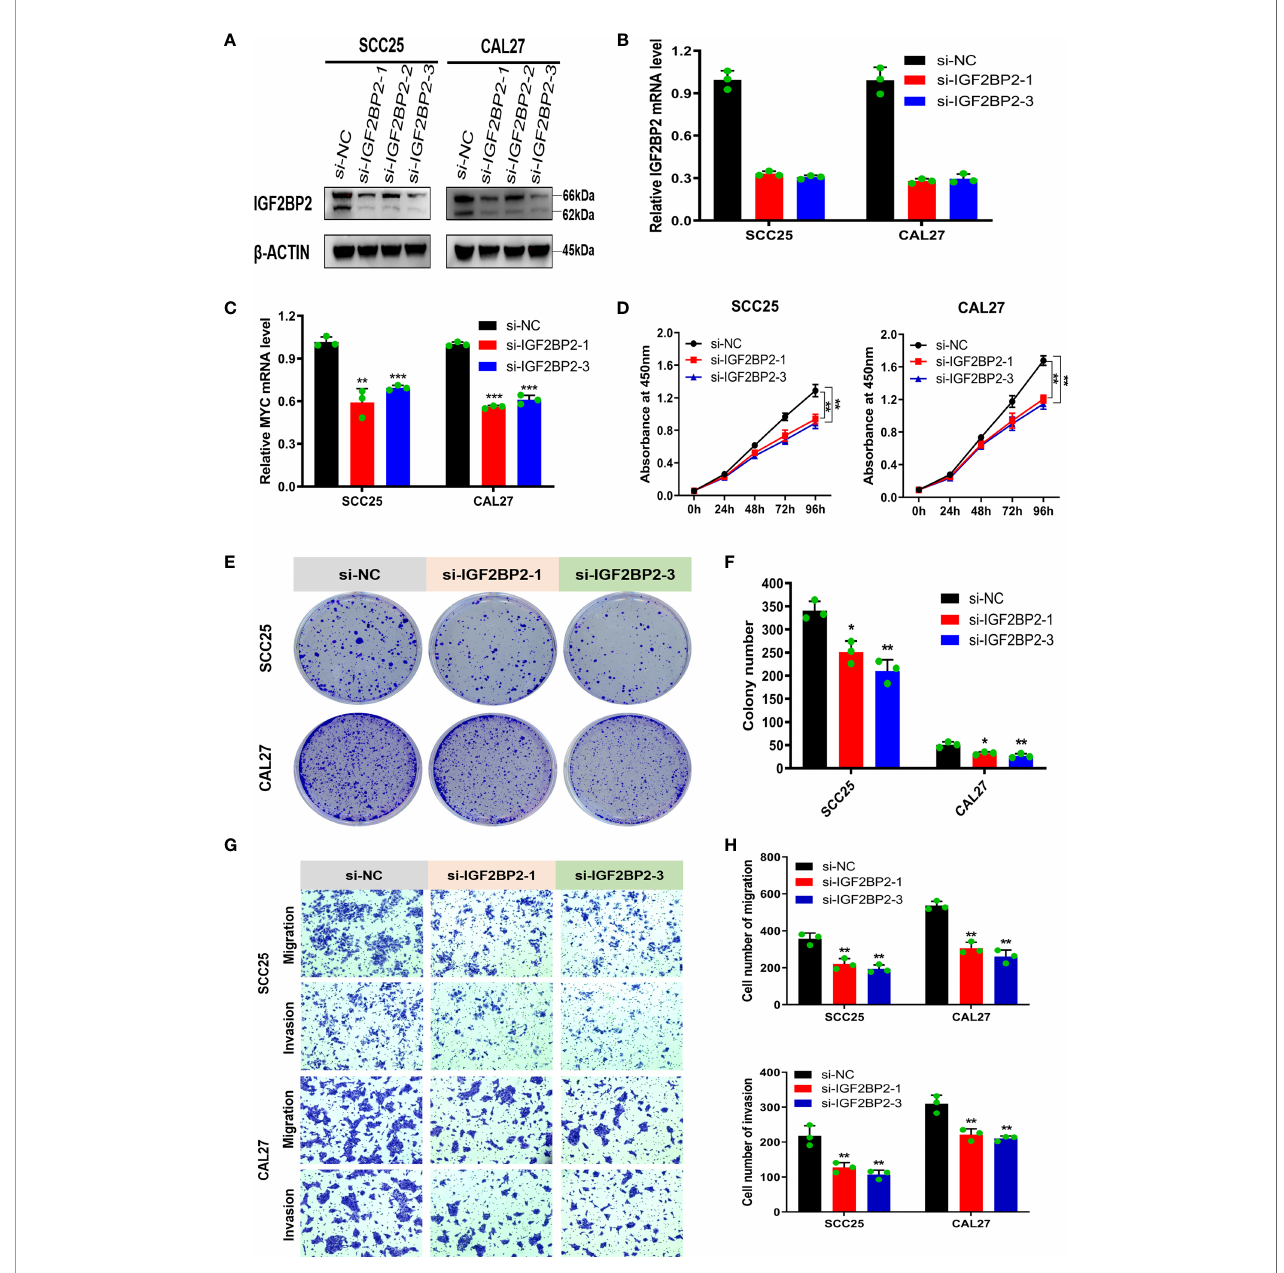
FIGURE 6 | Silencing IGF2BP2 inhibits the proliferation, migration, and invasion of OSCC cells in vitro . (A, B) Western blotting and qRT-PCR were performed to detect IGF2BP2 expression after transfection of siRNA. (C) The mRNA levels of MYC was detected by qRT-PCR in IGF2BP2-knockdown SCC25 and CAL27 cells. (D – F) The proliferation of NC and IGF2BP2-silenced SCC25 and CAL27 cells was detected using CCK-8 (D) and colony formation assays (E, F) . (G, H) Transwell assays were performed to assess migration and invasion in NC and IGF2BP2 knockdown SCC25 and CAL27 cells, which were photographed (G) and assessed (H) ; Magni fi cation at 100×. The experiment was repeated three times; error bars indicate standard deviation. * p < 0.05, ** p < 0.01, *** p <